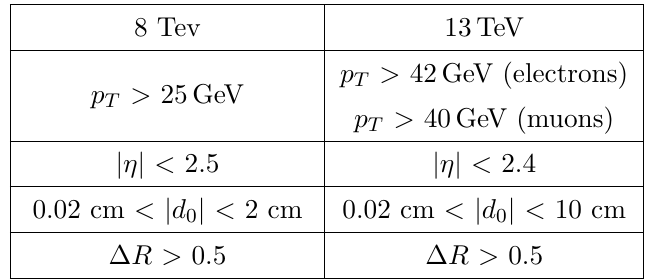
DL searches at CMS: cuts on the transverse momentum p transverse impact parameter d of the electron/muon and the angle ∆ R = p ∆ φ 2 + ∆ η 2 between 0 the electron and muon for the 8 and 13 TeV